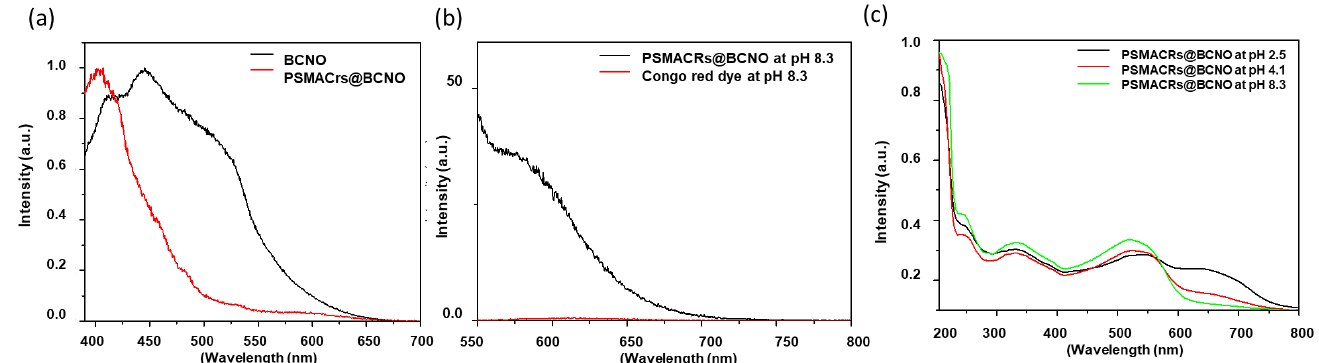
Figure 5. Photoluminescence spectrum of ( a ) BCNO (black trace) and PSMACRs@BCNO (red trace) upon excitation at 365 nm ( b ) Congo red dye only (red trance) and PSMACRs@BCNO (black trace) excited at 490 nm ( c ) UV-vis spectrum of the PSMACRs@BCNO at different pH values. Table 1. XPS surface elemental composition of BCNO and PEI@BCNO.